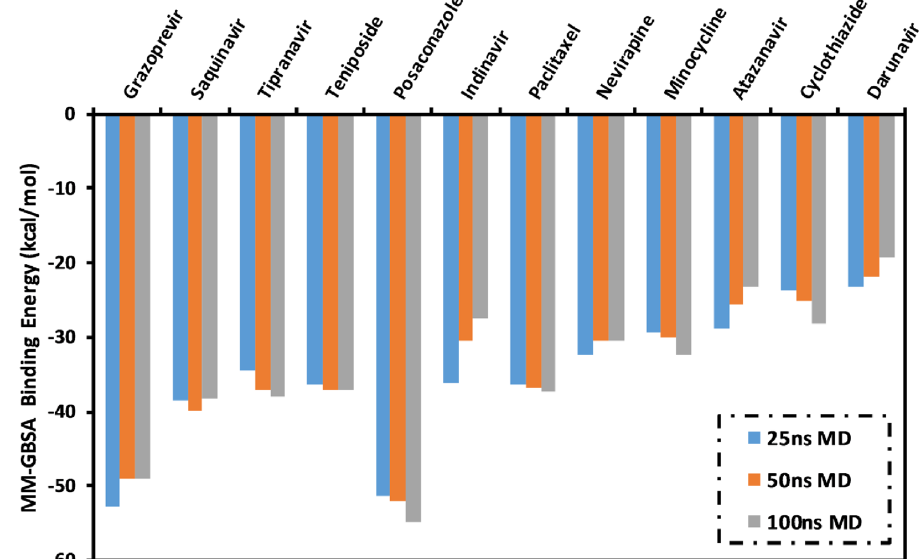
Figure 4. Calculated MM-GBSA binding energies for the investigated drugs as SARS-CoV-2 helicase inhibitors.